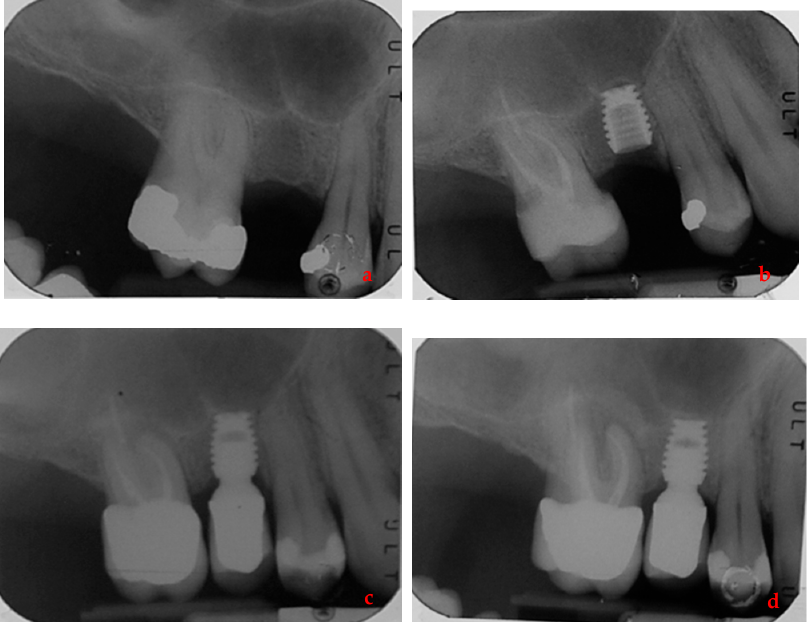
Figure 4. Single implant placed in 1.5 site (4.5 × 6 mm) of a male patient with history of periodontal disease: ( a ) pre-operative radiograph before implant placement; ( b ) radiograph obtained at implant placement; ( c ) radiograph obtained at time of loading; ( d ) radiograph obtained at 3-year follow-up.